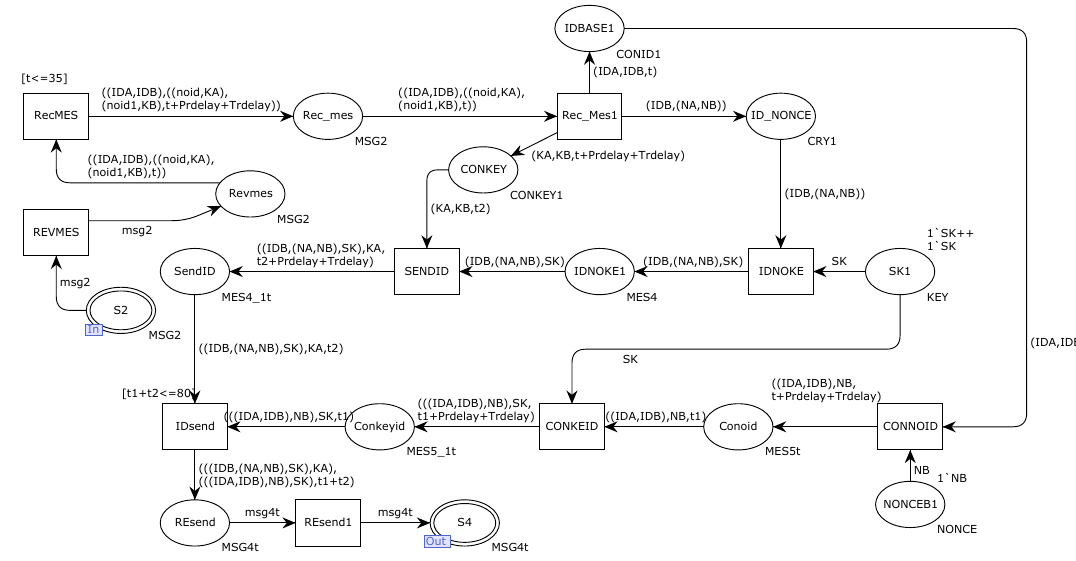
Figure 11. Internal model of improved solution